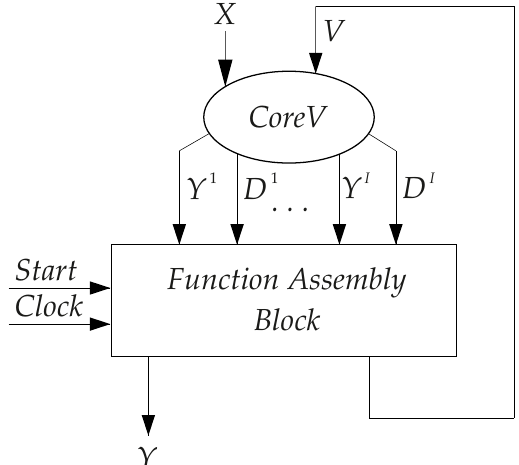
Figure 3. Generalized diagram of P T Mealy